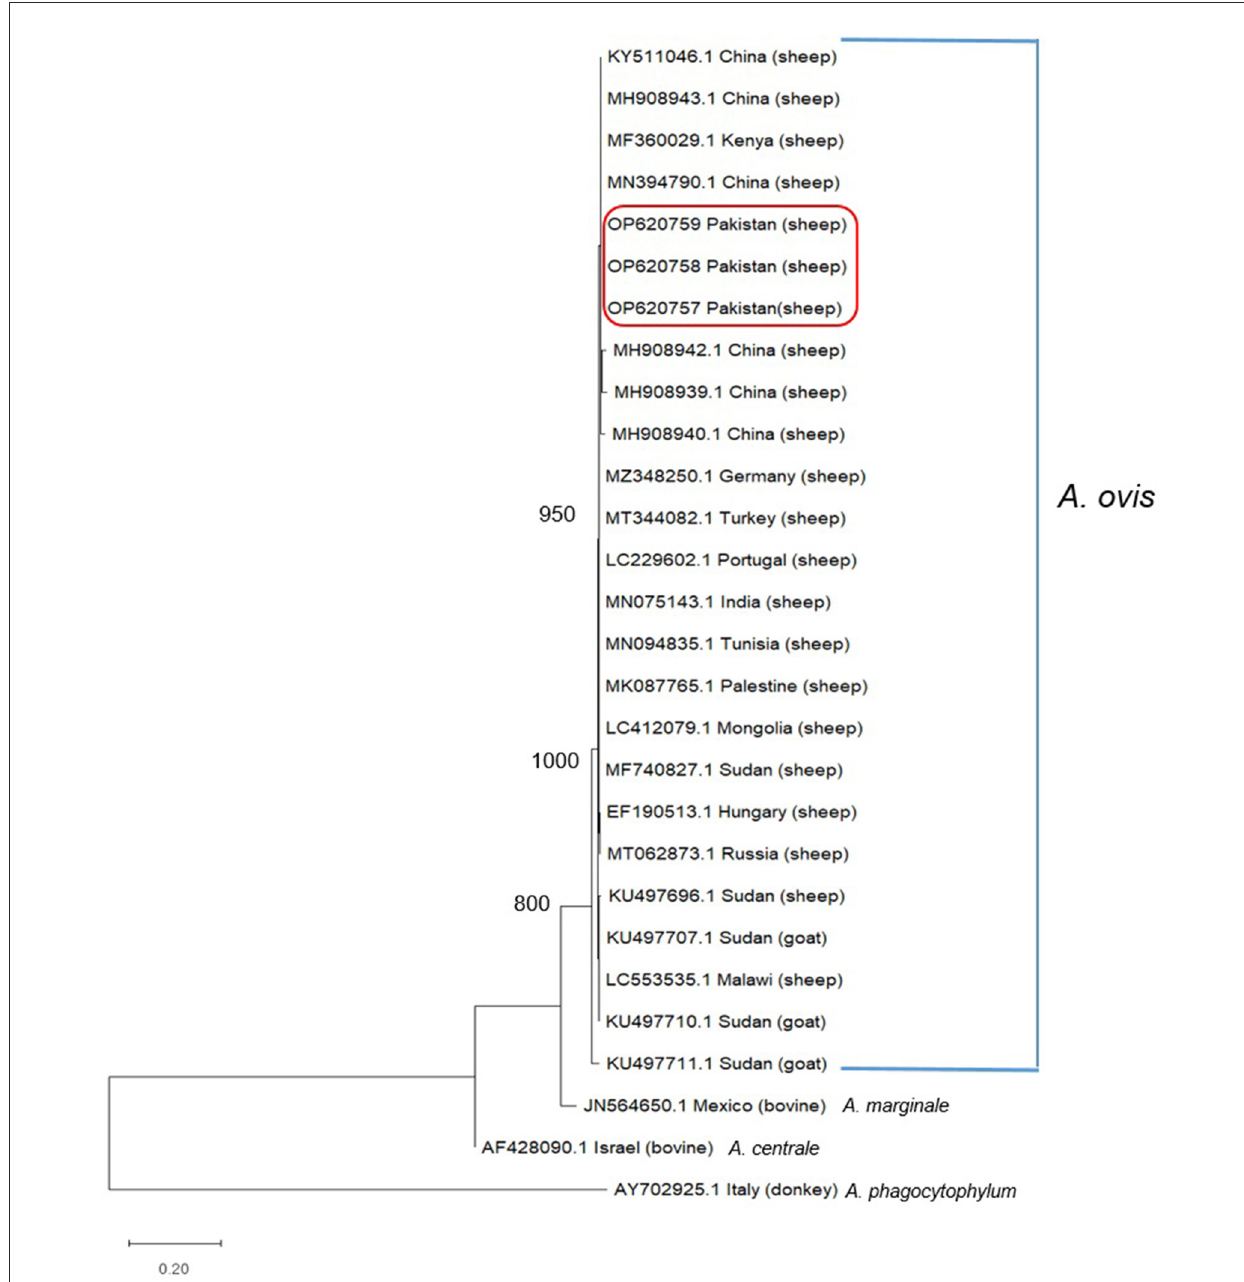
FIGURE2 msp4 sequence alignment from Anaplasma ovis isolates amplified from Pakistani sheep and the sequences deposited in GenBank from various parts of world. Dashes indicate the conserved nucleotide positions. The positions with substitutions in DNA sequence of various Anaplasma spp. are represented by different colored